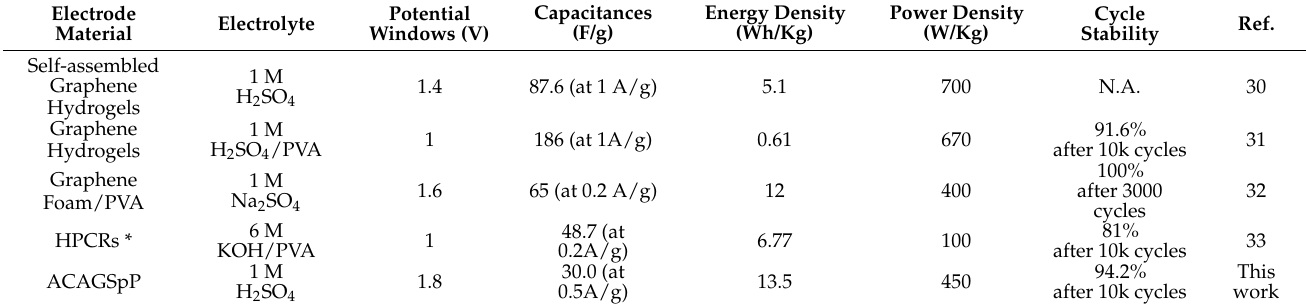
Figure 4. (color online) ( a ) Nyquist plot of symmetric aqueous SCs employing ACAGSpP or ACPVDFSpP electrodes; ( b ) cycling performance and coulombic efficiency of symmetric ACAGSpP SCs with operating voltage of 1.8 V at 2 A/g for 10,000 cycles, and ( c ) Ragone plot of gravimetric energy density versus gravimetric power density for ACAGSpP electrodes (this work) in comparison with other reported high-voltage symmetric aqueous carbon–carbon SCs. Table 2. Comparison of carbon-based symmetric